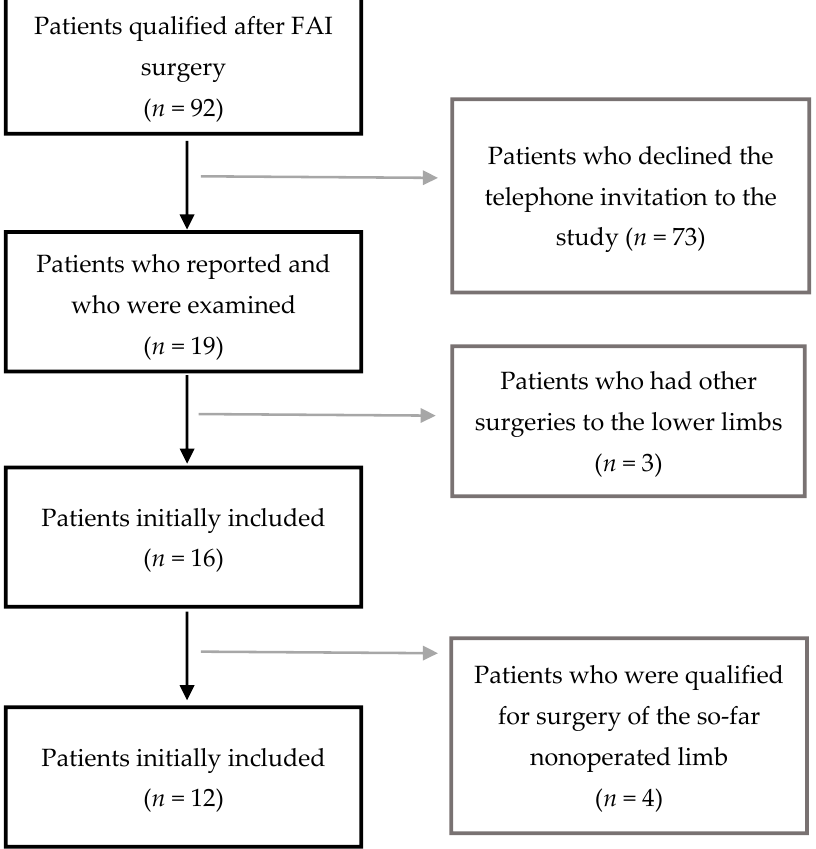
Figure 1. Study inclusion process .